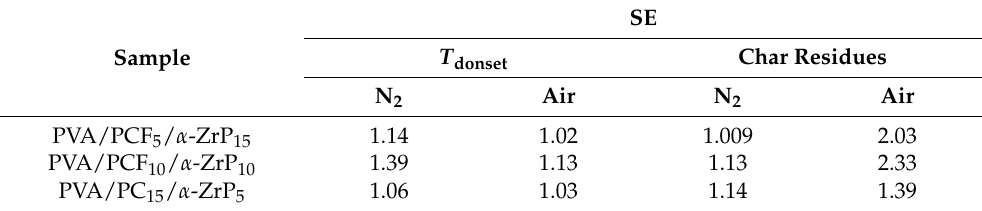
Table 1. SE values of aerogel with TGA data.